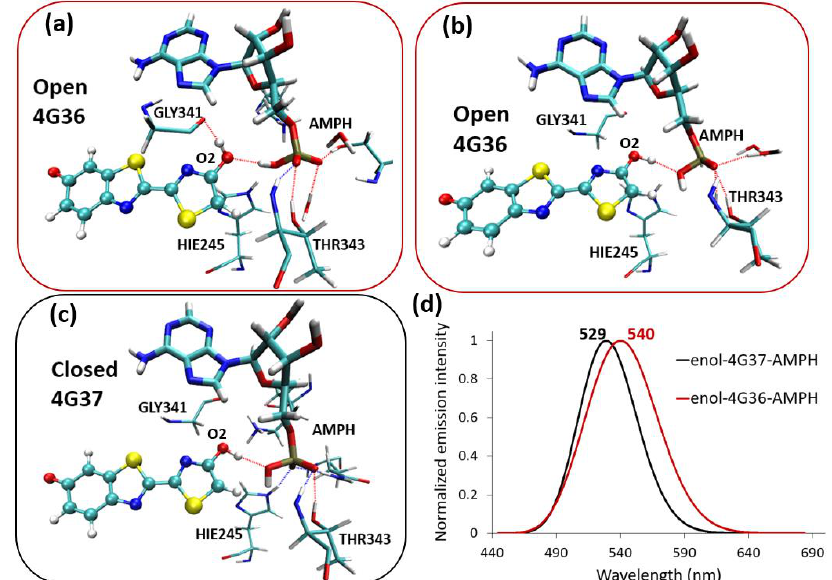
Figure 5. Graphical representation of the hydrogen-bond patterns found along the simulations of ( a ) enol-4G36-AMPH involving GLY341 and AMPH − (pattern 1), ( b ) enol-4G36-AMPH involving only AMPH − (pattern 2) and ( c ) enol-4G37-AMPH (pattern 2). ( d ) Simulated emission spectra for enol-4G36-AMPH (red) and enol-4G37-AMPH (black).